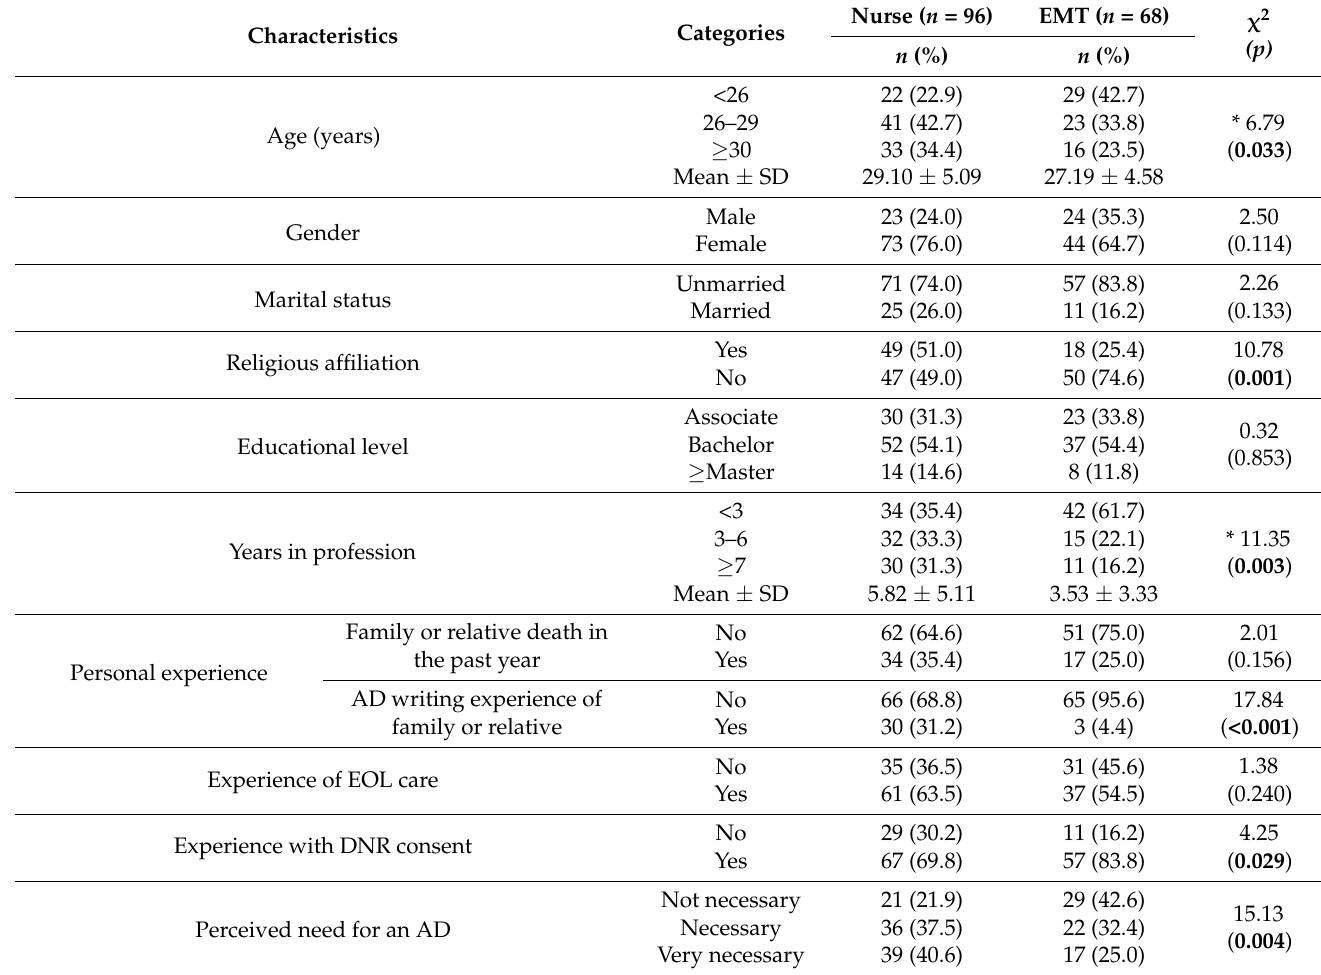
Table 1. General characteristics of participants ( n =